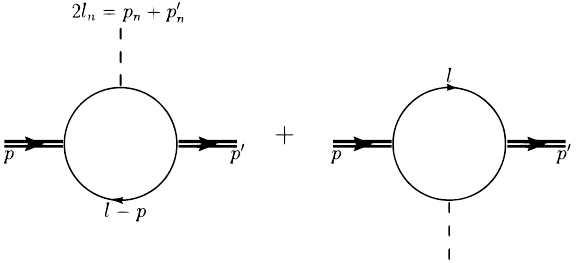
Figure 1 . Fermion propagator in momentum space. Dashed line represents the momentum re- (cid:13)ected from the boundary. First term corresponds to standard propagator i=p and the second p 2 term corresponds to the re(cid:13)ected propagator i= ~ p with ~ p = ( p; (cid:0) p n ). Note that the momentum p 2 non-conservation through re(cid:13)ected propagator is denoted by the dashed line with p n (cid:17) (0 ; p n ).